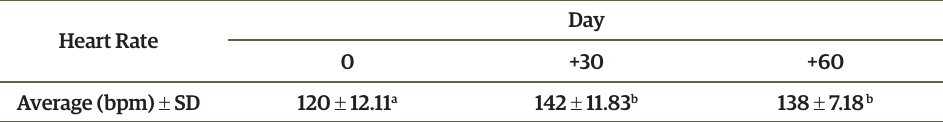
Table 1. Heart rate distribution, in beats per minute, recorded during the physical assessment of brachycephalic dogs, from January 2018 to December 2018, in the city of Seropédica, before (day 0) and after the rhinoplasty procedure (days +30 and +60).